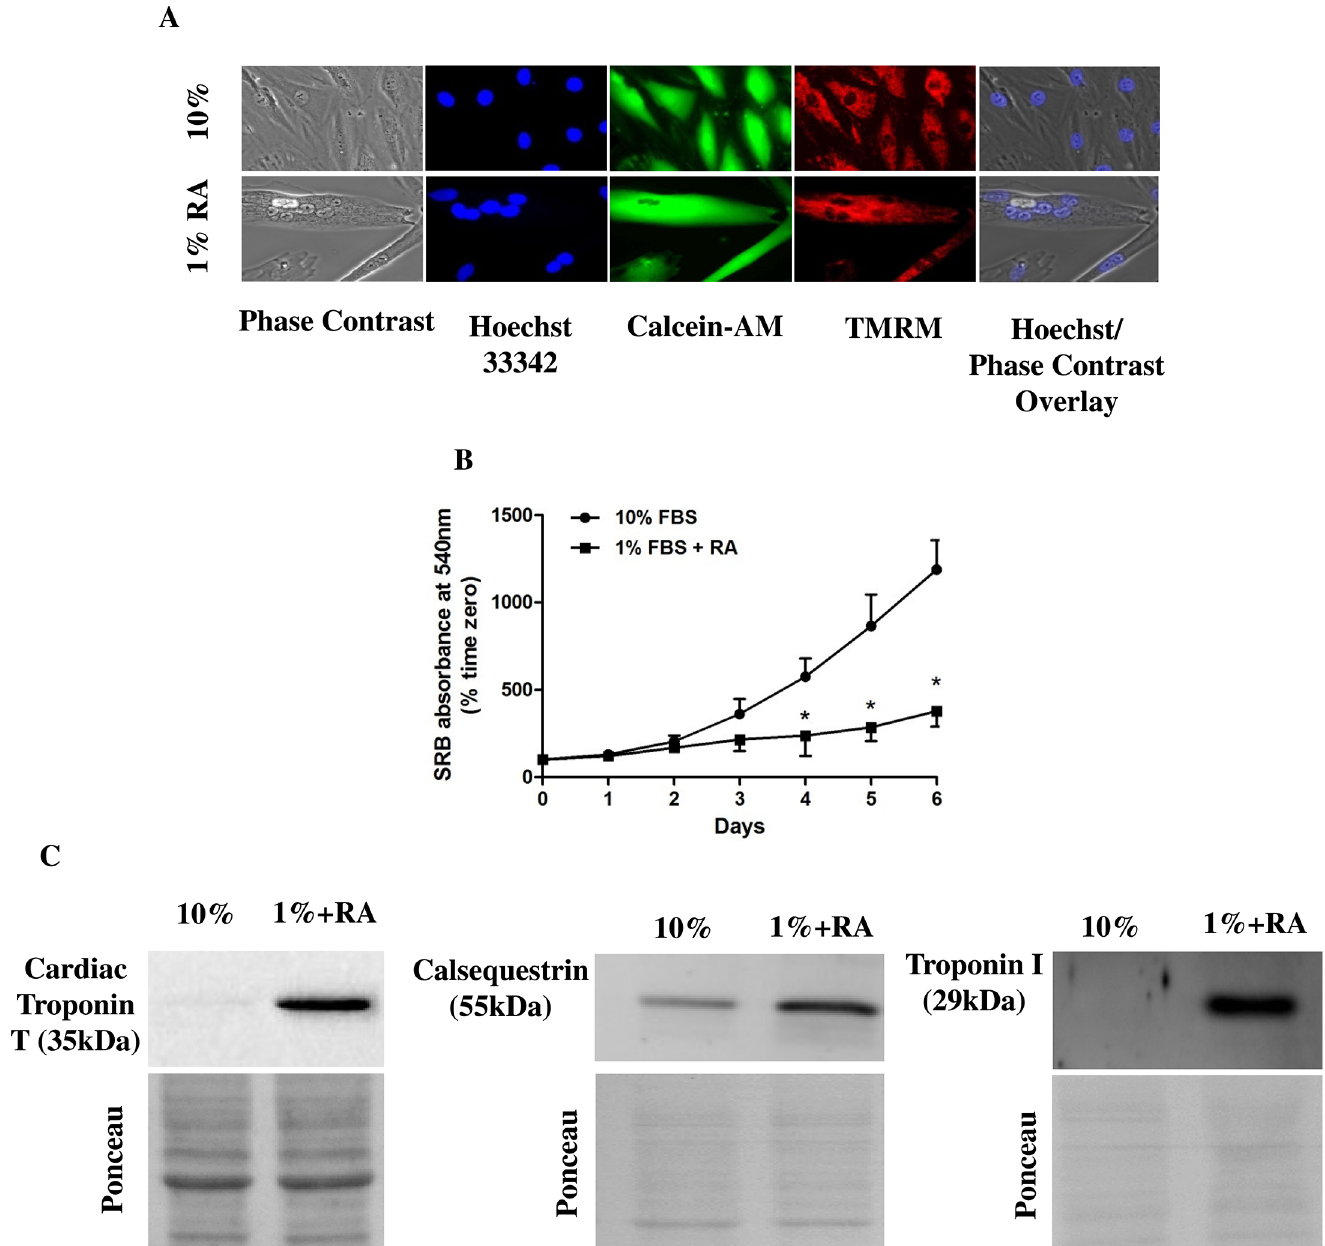
Fig 1. Morphologic and molecular characterization of H9c2 cell line before and after the differentiation process. A) Representative images of the effect of serum withdrawal and RA supplentation on H9c2 cell morphology. Morphologic alterations were observed using the fluorescent probes Hoechst 33342 (nucleus, blue), Calcein-AM (cell viability, green) and TMRM (mitochondria, red). An overlay of phase contrast and Hoechst labeling is also shown. H9c2 cells cultured in 10% FBS-containing medium (top panels) showed a stellar shape, in the most cases, with one nucleus per cell. Upon culture in a medium containing 1% of FBS supplemented with 1 α M RA (bottom panels), differentiated H9c2 cells showed an elongated shape with several nuclei. Epifluorescence microscopy images are representative of 4 different cell preparations. White bar represents 10 μ m. B) Decreased proliferative rate by modulating the percentage of serum in the medium. H9c2 cells were seeded at a density of 5,000 cells/ml and allowed to proliferate during 6 days in presence of RA. Results were analyzed by using the SRB assay. Undifferentiated H9c2 cells incubated in a high-serum medium proliferate fast, while incubation in a low-serum medium with daily RA additions during 5 days promoted cell cycle arrest. Statistical analysis: * p < 0.05 vs 10% FBS; the graph is representative of 5 independent experimental studies. C) Cellular content of specific cardiac marker troponin T, troponin I and cardiac calsequestrin in different cell populations. By using Western blotting, it was possible to confirm that RA-differentiated cells have increased content of cardiac markers. The images are representative of 4 different experimental studies which produced the same result. Ponceau labeling represents the loading control and was used to normalize data.